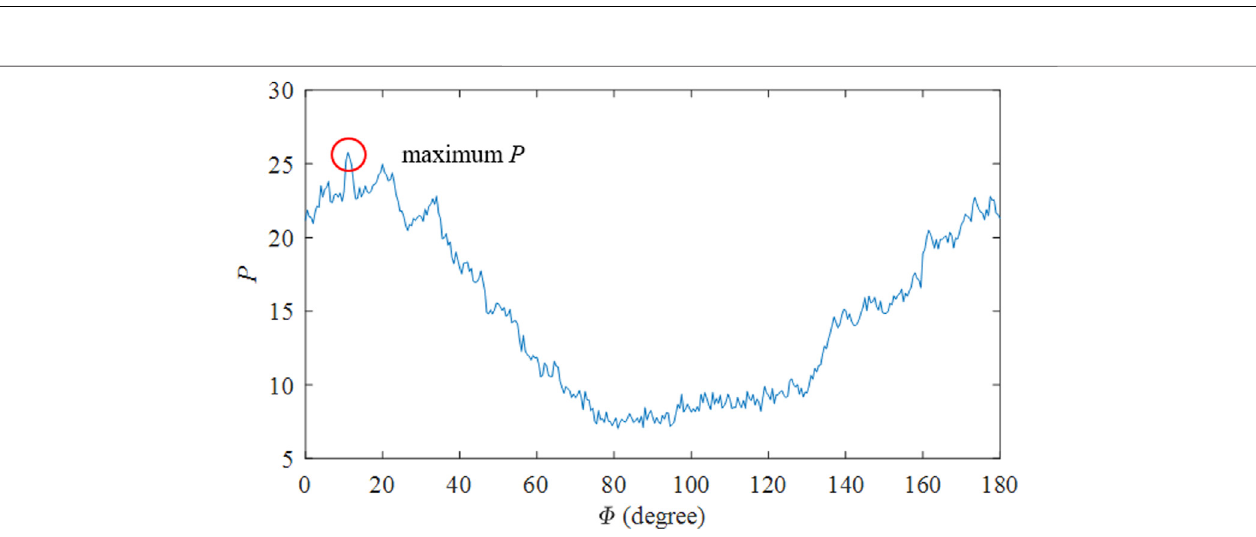
FIGURE 5 | the p value for 0 ° < Φ < 180 ° . The rotation angle Φ corresponding to maximum p is the direction of the fl ow velocity at this point to be measured.